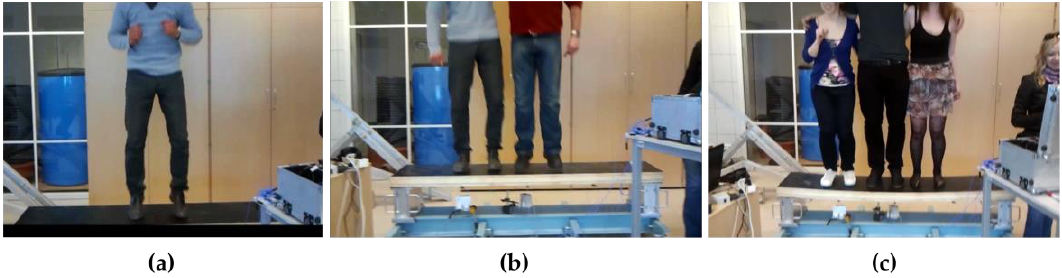
Figure 12. Implementation of excited vibrations in the form of rhythmical jumps of ( a ) one person, ( b ) two people, ( c ) three people .